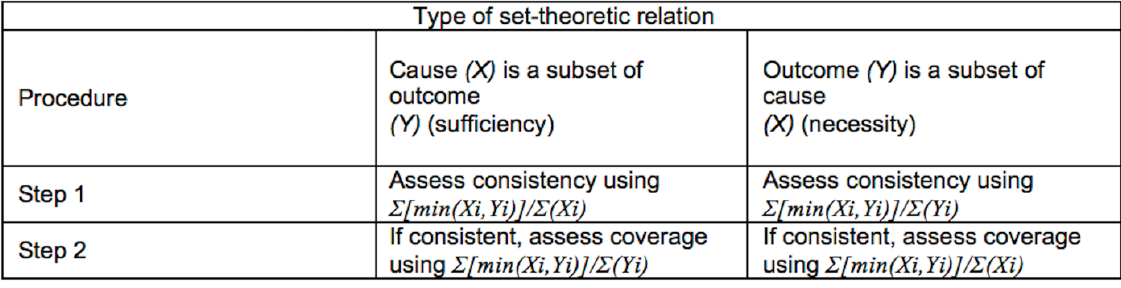
Figure 1. Assessing consistency and coverage (Ragin, 2008;